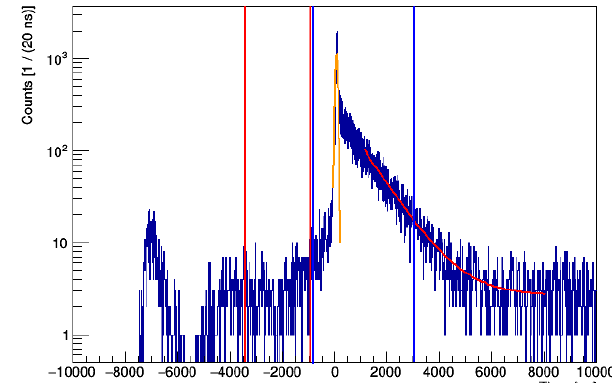
Fig. 10. Time spectrum of the arrival time of pulses in a peripheral SiPM, after subtraction of the time of the beginning of the light emission from the source. The vertical blue and red lines show the signal and background time windows used in counting analysis. The red curve indicates a fit of the triplet component including a flat background